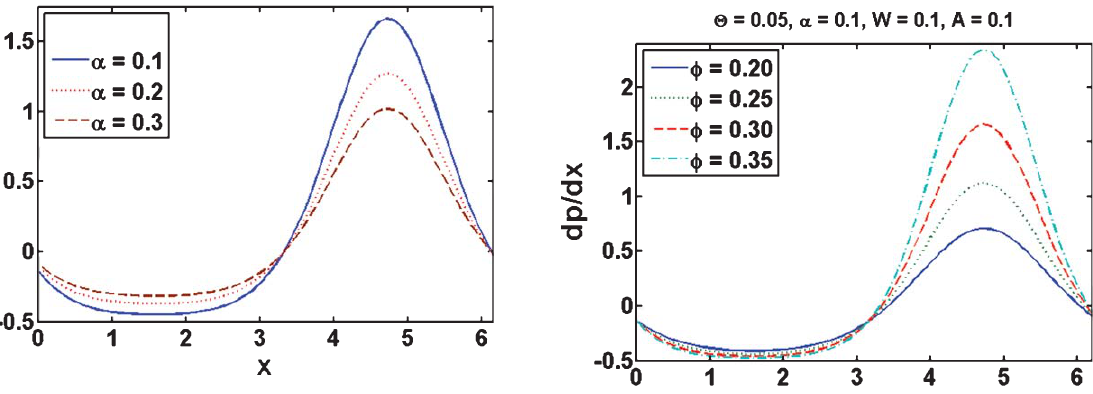
Fig. 12. Variation in dp/dx against x for different values of fluid parameter ( W ).